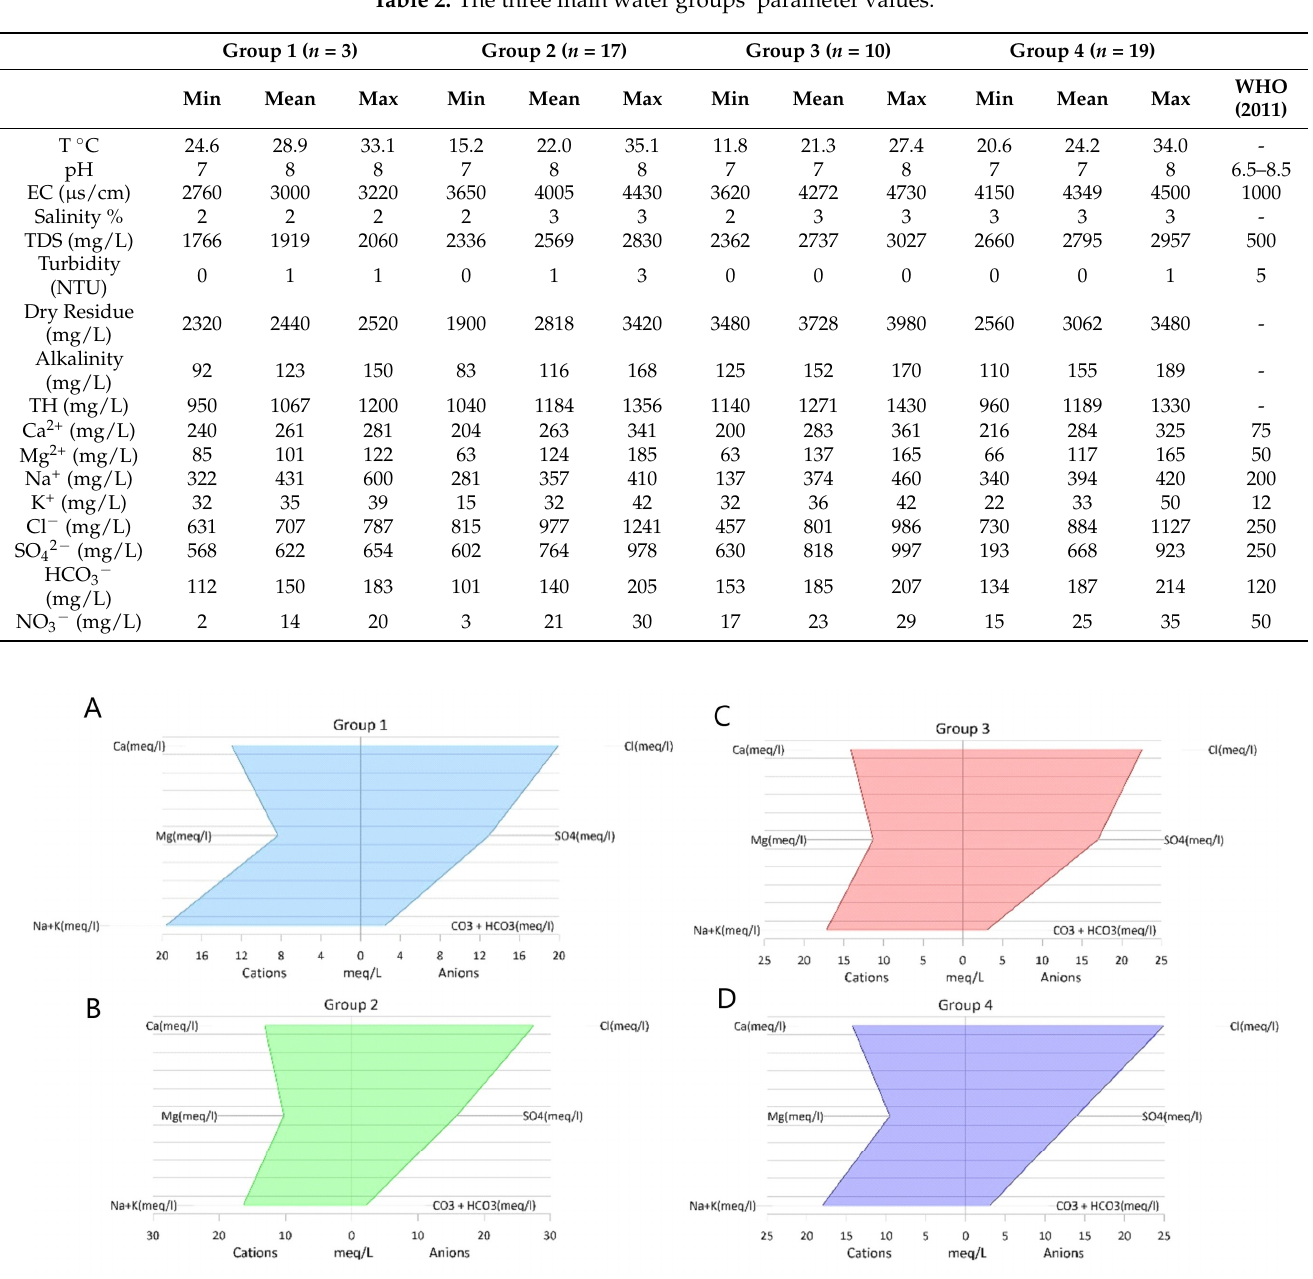
Table 2. The three main water groups’ parameter values.